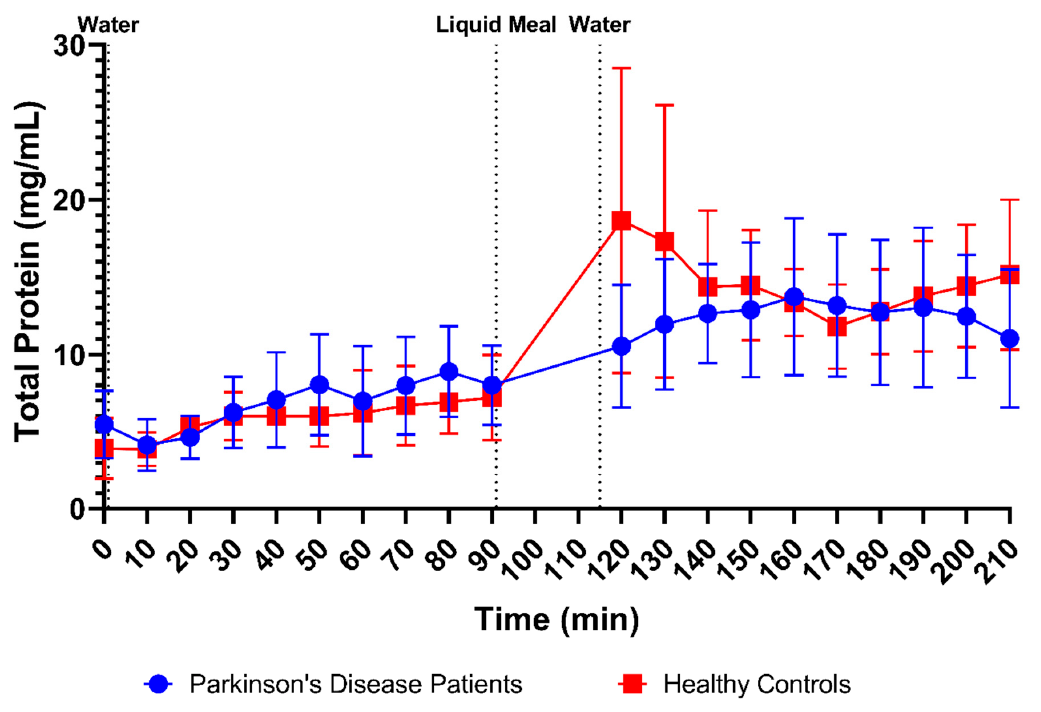
Figure 7. Time-dependent evolution of the total protein concentration in duodenal fluids aspirated from Parkinson’s disease patients ( n = 9, blue circles) and healthy controls ( n = 9, red squares). Data points represent the mean ± standard deviation; vertical dotted lines indicate the ingestion of 100 mL of water or 200 mL of liquid meal.